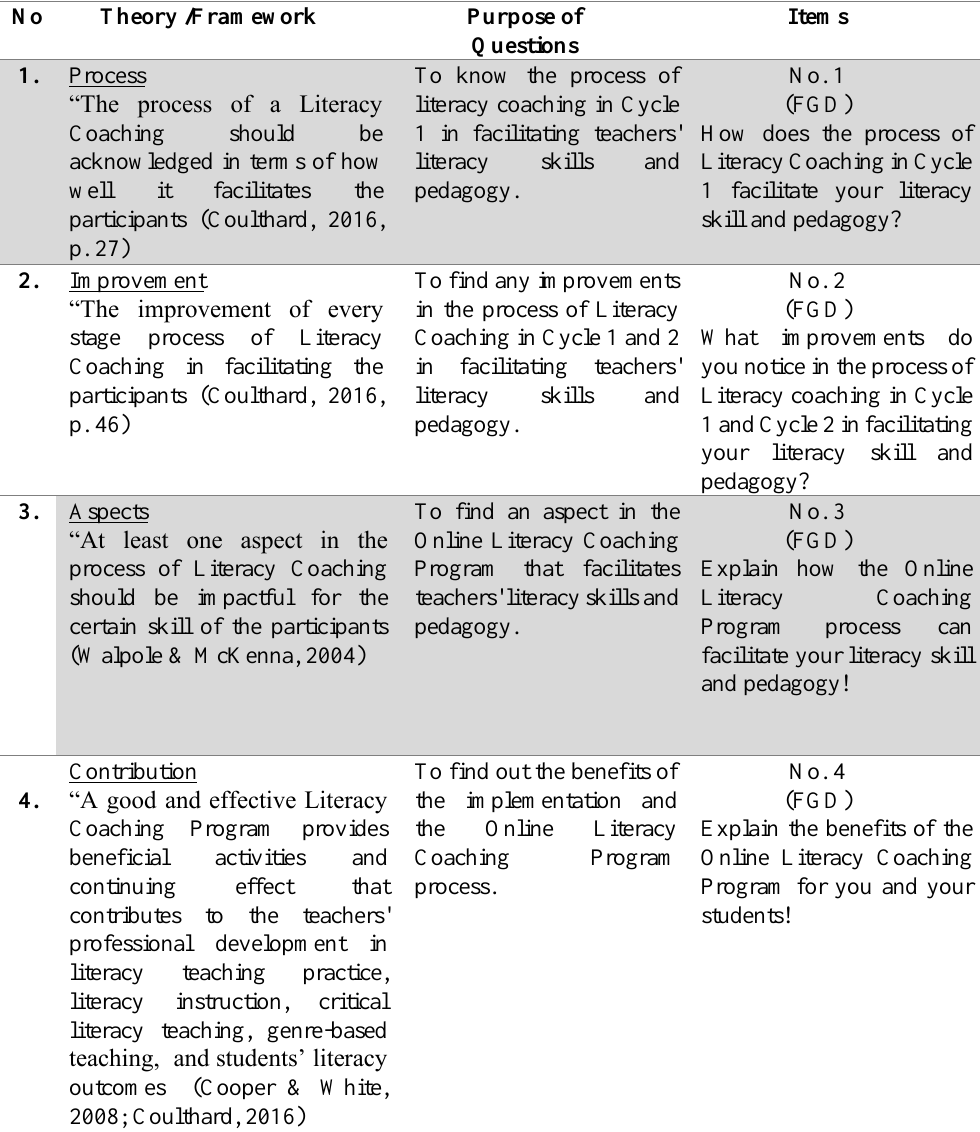
Table 1: Interview